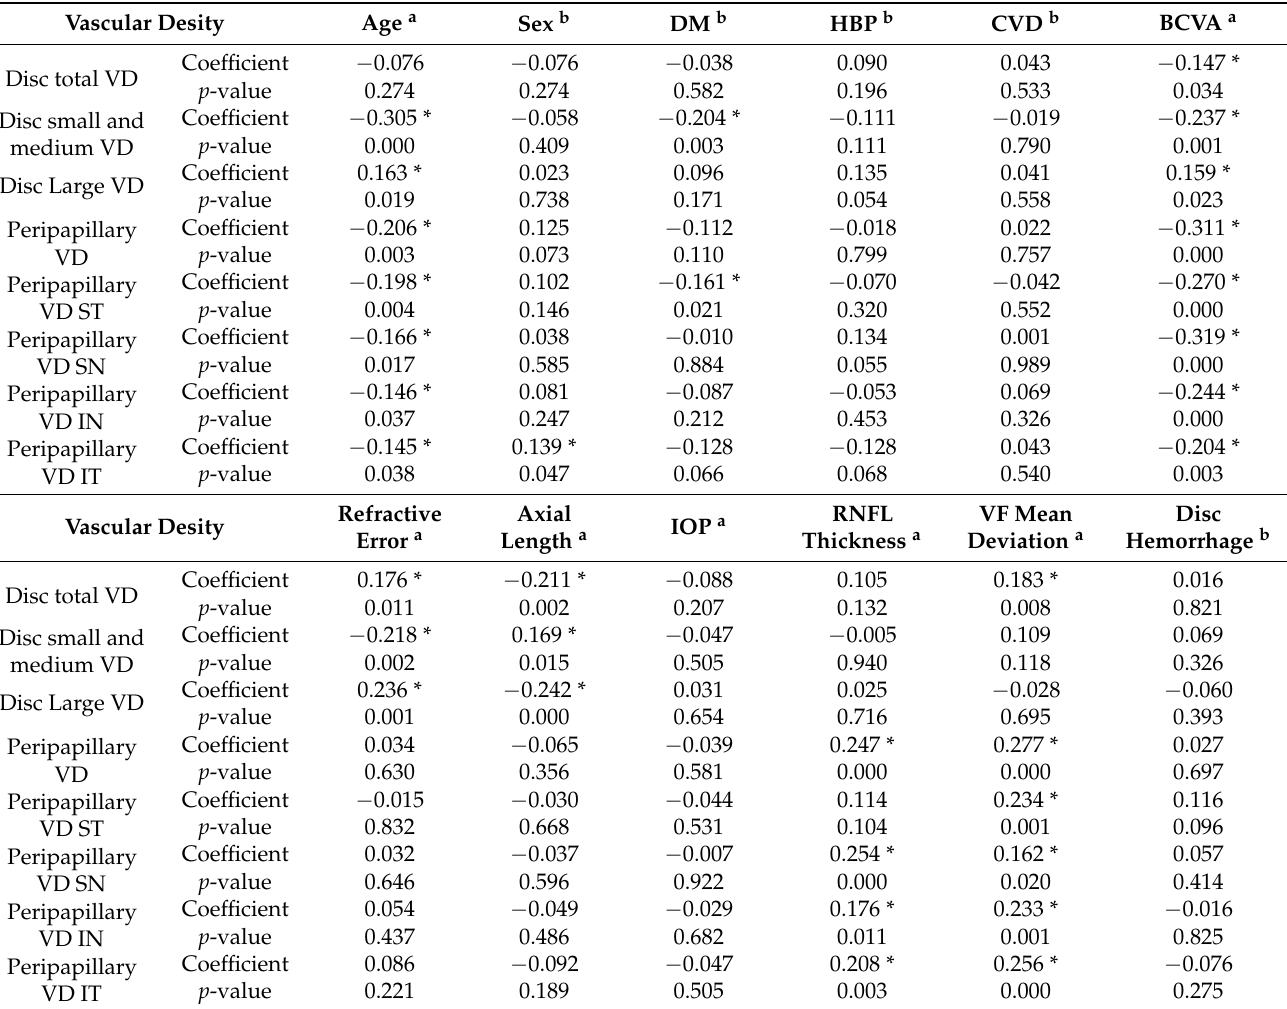
Table 4. Correlation between vascular density and clinical